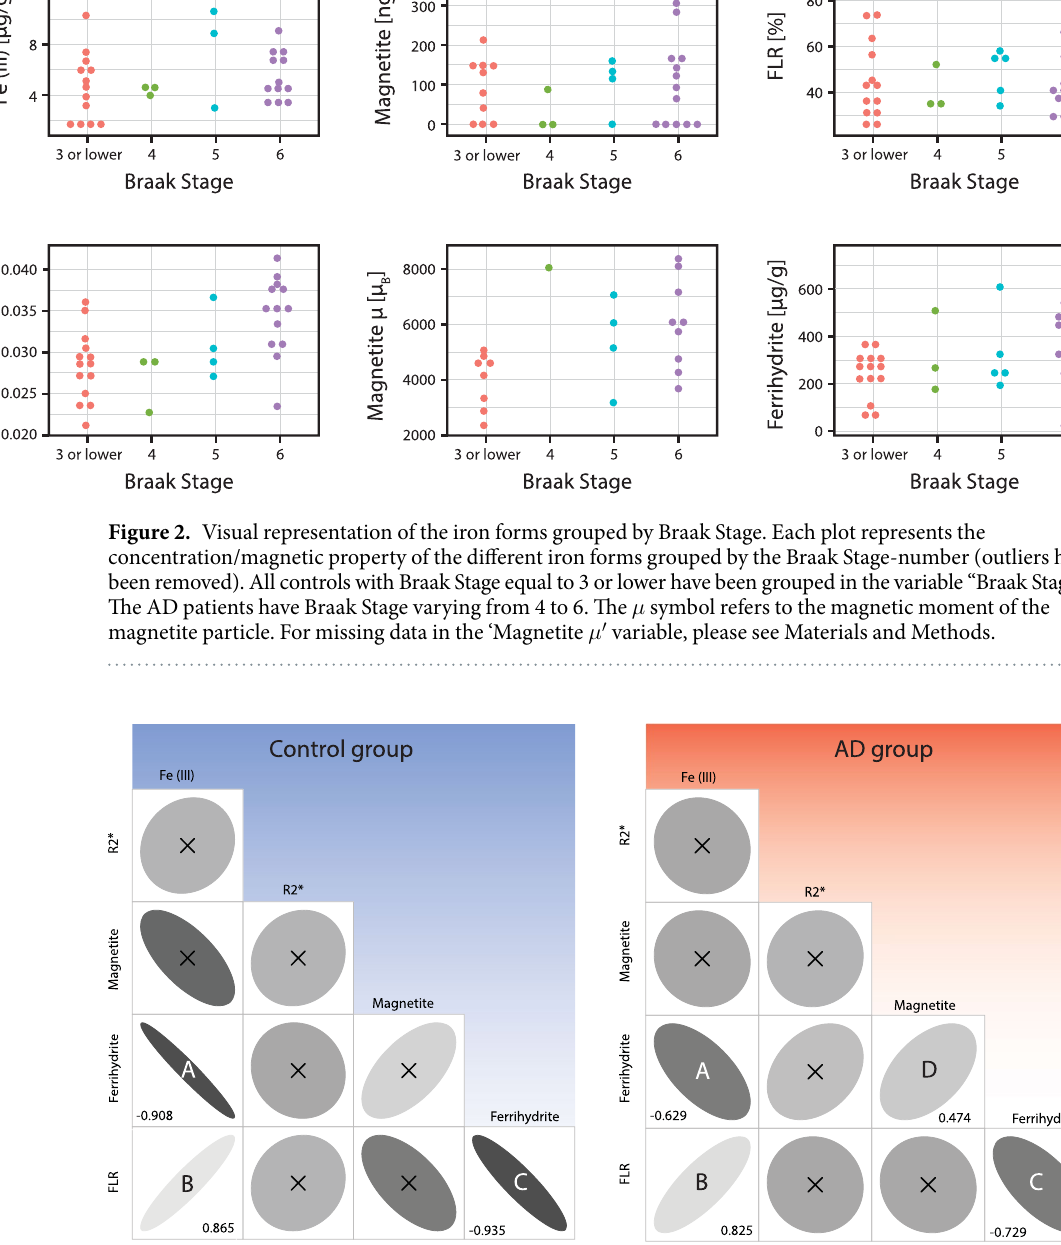
the tissue, while its magnetic moment is related to the iron loading of the protein. Typically, 4500 iron atoms per protein are considered to be the maximum which the core can store in vitro . However, in vivo loading may be lower: some studies reported a loading of 1500 atoms in vivo 70,71 , corresponding to roughly 33% of the protein capacity. Other findings show that, when ferritin is fractionated by density gradient centrifugation, the full range